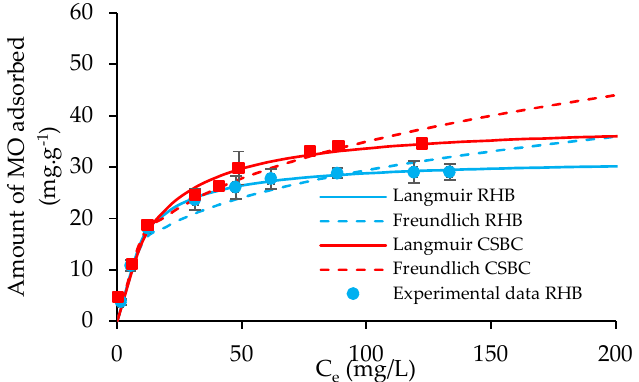
Figure 6. Fitting of Langmuir and Freundlich isotherms for MO adsorption on RHB and CSBC. Table 1. Fitting results of Langmuir and Freundlich isotherms for MO adsorption by RHB and CSBC.